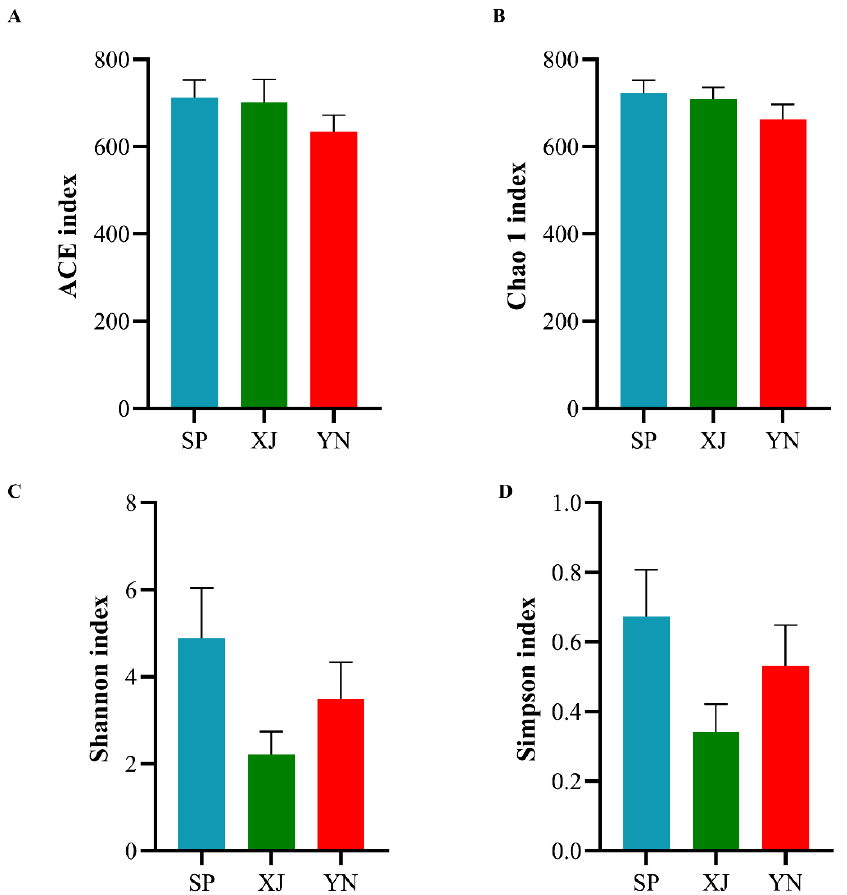
Figure 2. Analysis of alpha diversity indices of gut bacteria in T. absoluta from different geographical populations. Abbreviations: SP, Spain; XJ, Xinjiang; YN, Yunnan. ( A ) ACE index. ( B ) Chao 1 index. ( C ) Shannon index. ( D ) Simpson index.